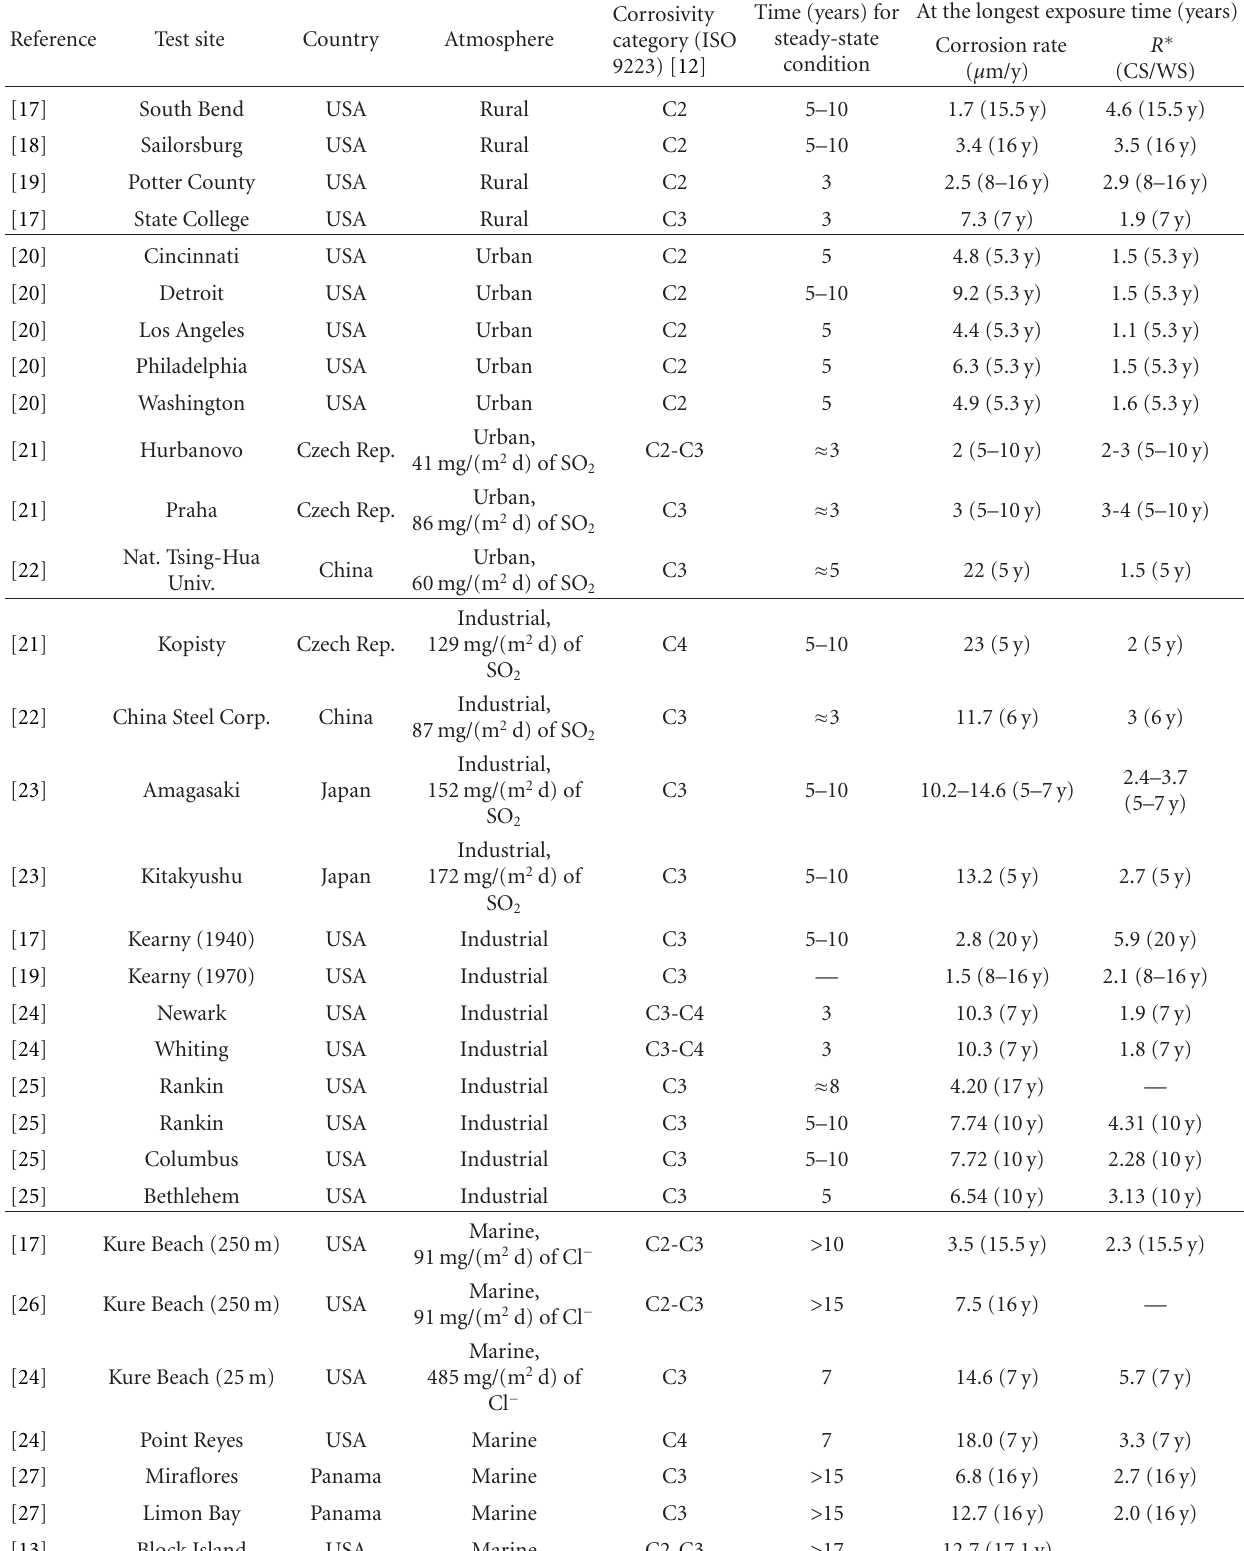
Table 2: Compendium of bibliographic information on evolution of atmospheric corrosion of conventional WS with time of exposure.